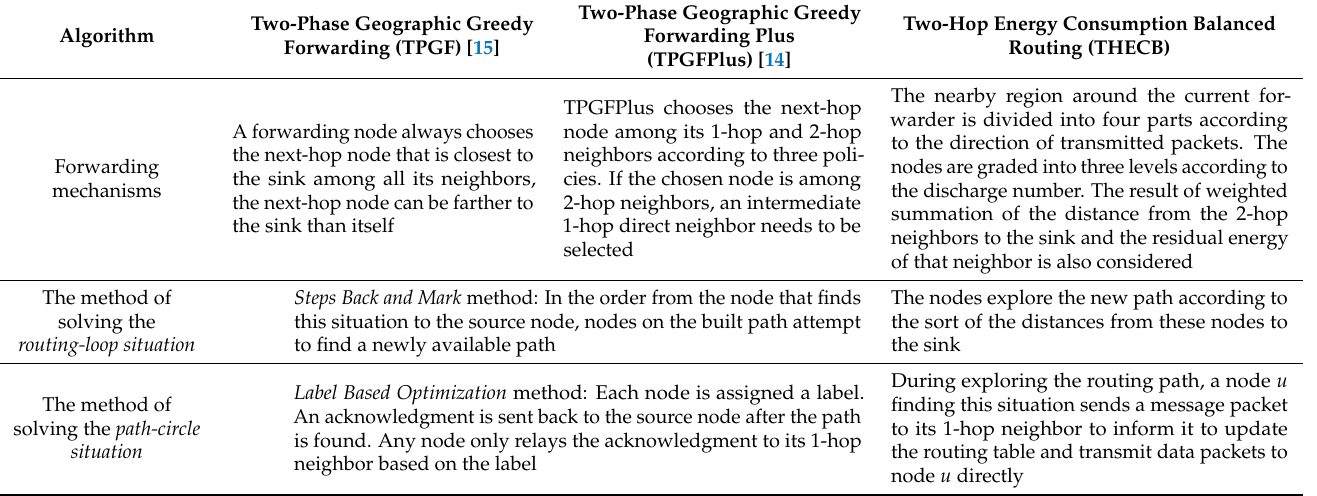
Table 3. The comparison of TPGF, TPGFPlus and